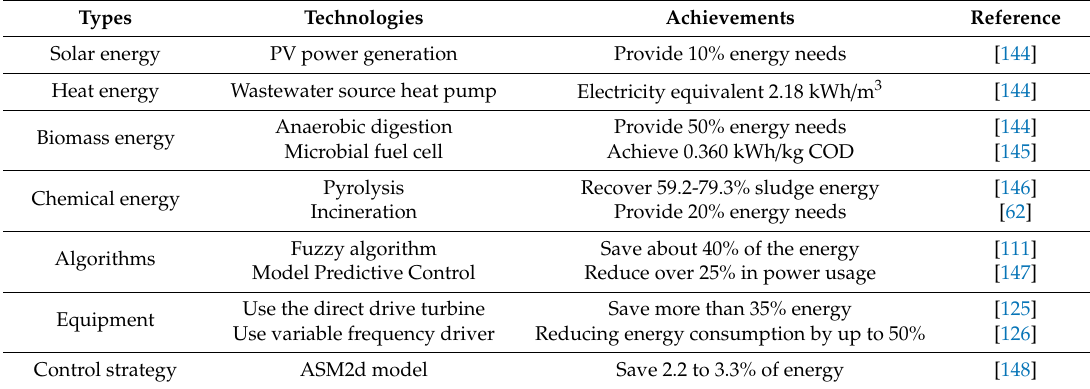
Table 6. Energy consumption of WWTPs using common green energy technologies.